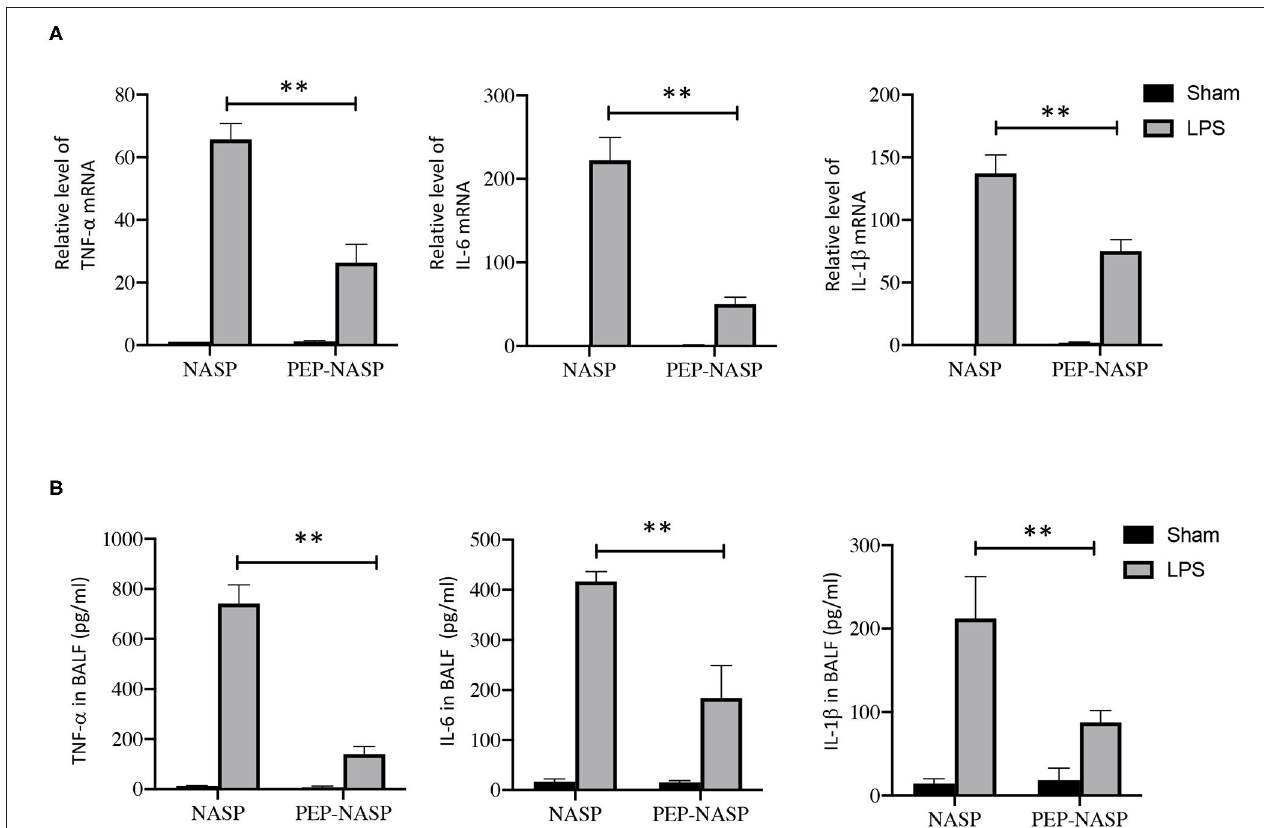
FIGURE 7 | The PEP-NASP reduced expressions of TNF- α , IL-6, and IL-1 β in mice treated with LPS. (A) RNA expressions of TNF- α , IL-6 and IL-1 β in lung tissues were determined by an RT-qPCR. (B) Levels of proinflammatory factors (TNF- α , IL-6, and IL-1 β ) in bronchoalveolar lavage fluid (BALF) were detected by an ELISA. N = 10, ** p < 0.01 (by a one-way